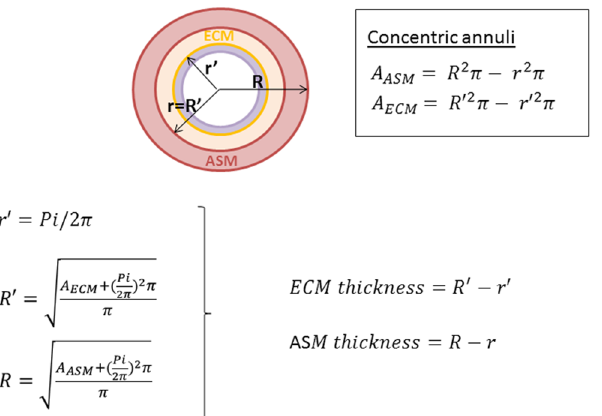
Fig 3. Scheme of a distended bronchial wall. In our mathematical model, the bronchial wall was treated as a structure composed of multiple concentric annuli. Excluding the inner annulus, representing the epithelial layer (in purple, negligible in thickness), we considered the submucosa as composed by two annuli representing the ECM (yellow) and ASM (pink). Pi corresponded to the yellow circumference in our model.